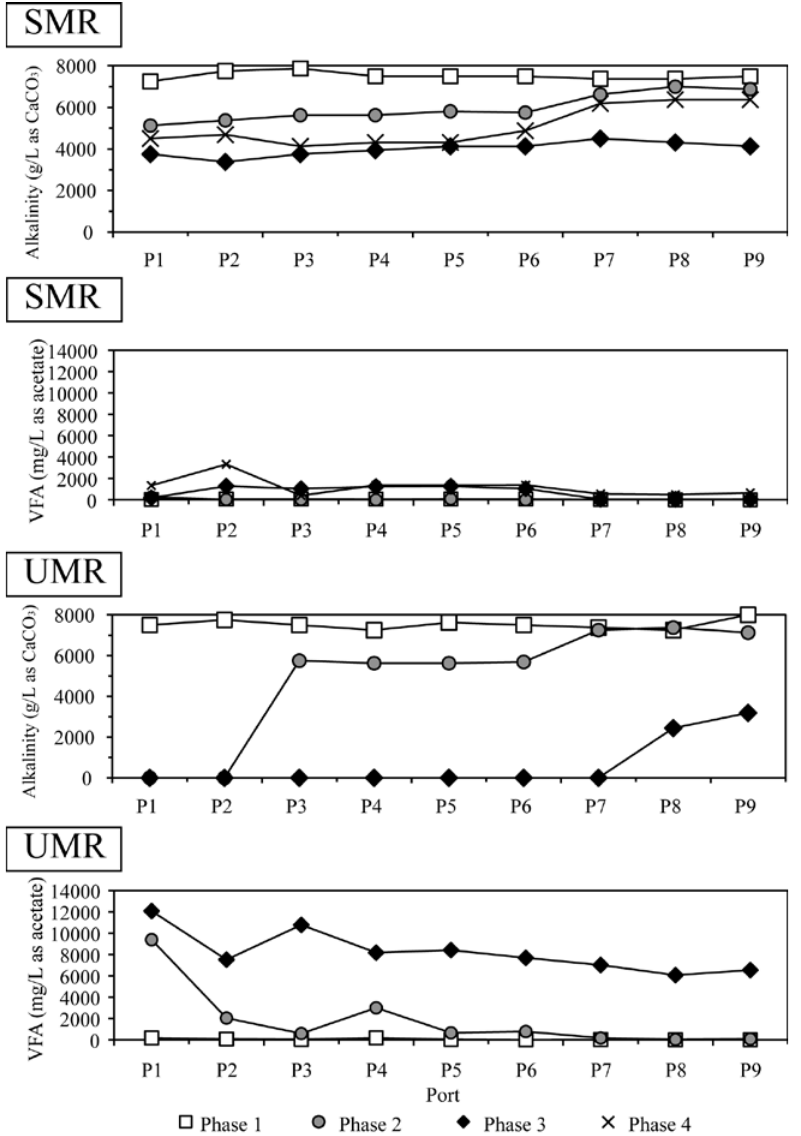
Figure 2. Variation patterns of VFA and alkalinity concentrations in the SMR and